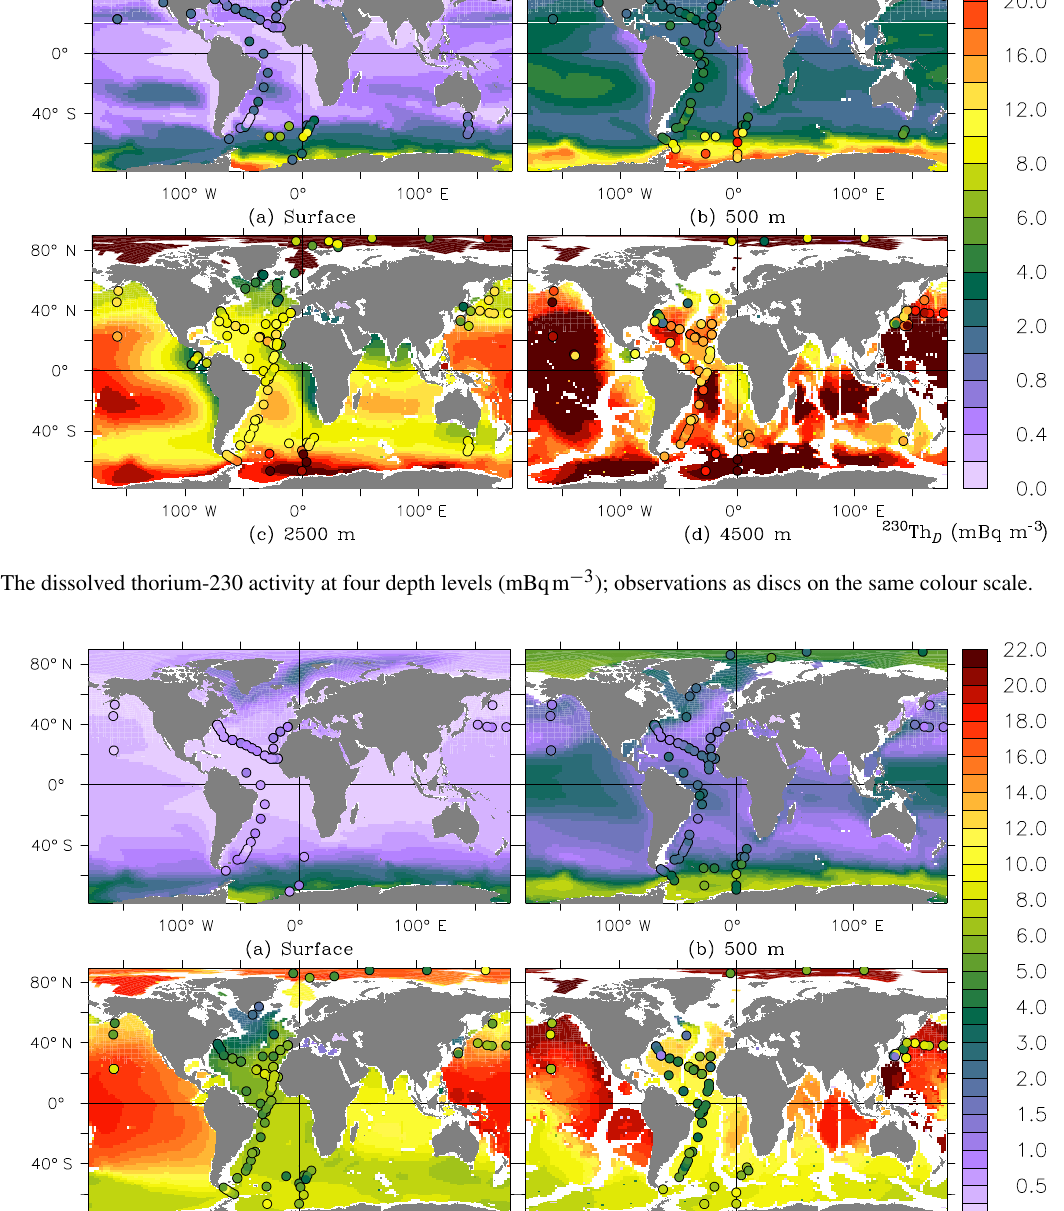
and 231 Pa. However, the model still underestimates the ob- served [ 230 Th ] S and [ 230 Th ] B